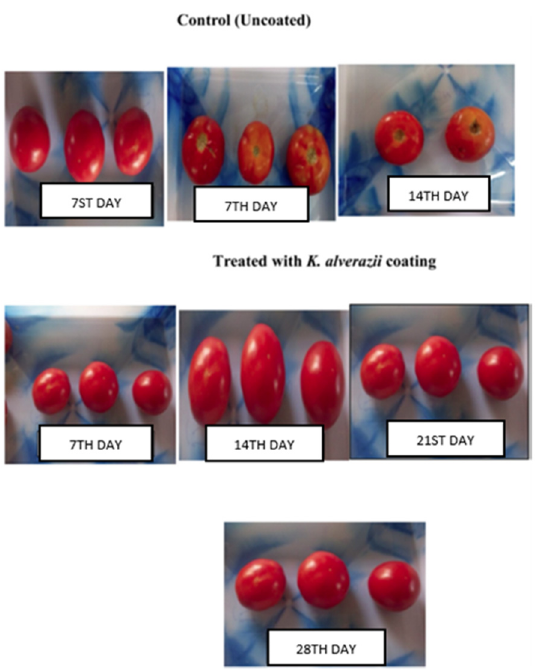
Figure 3. Texture of uncoated and Kappaphycus alvarezii (red algae) coated tomatoes during storage [61].